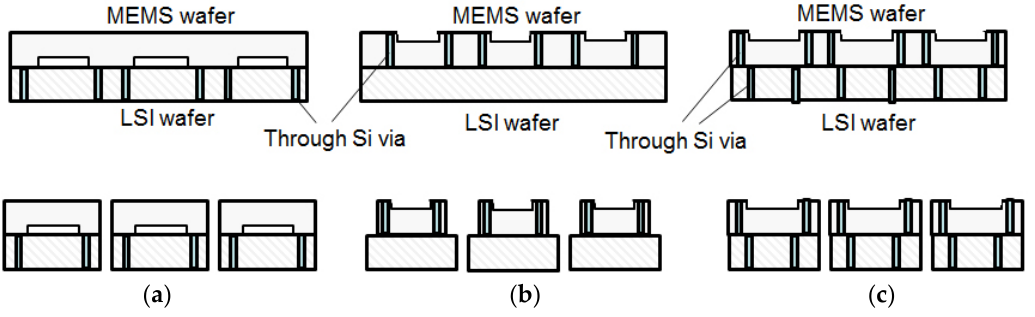
Figure 9. Stacked integration using through Si vias (TSVs); ( a ) LSI wafer vias; ( b ) MEMS wafer vias; and ( c ) LSI wafer vias and MEMS wafer vias.